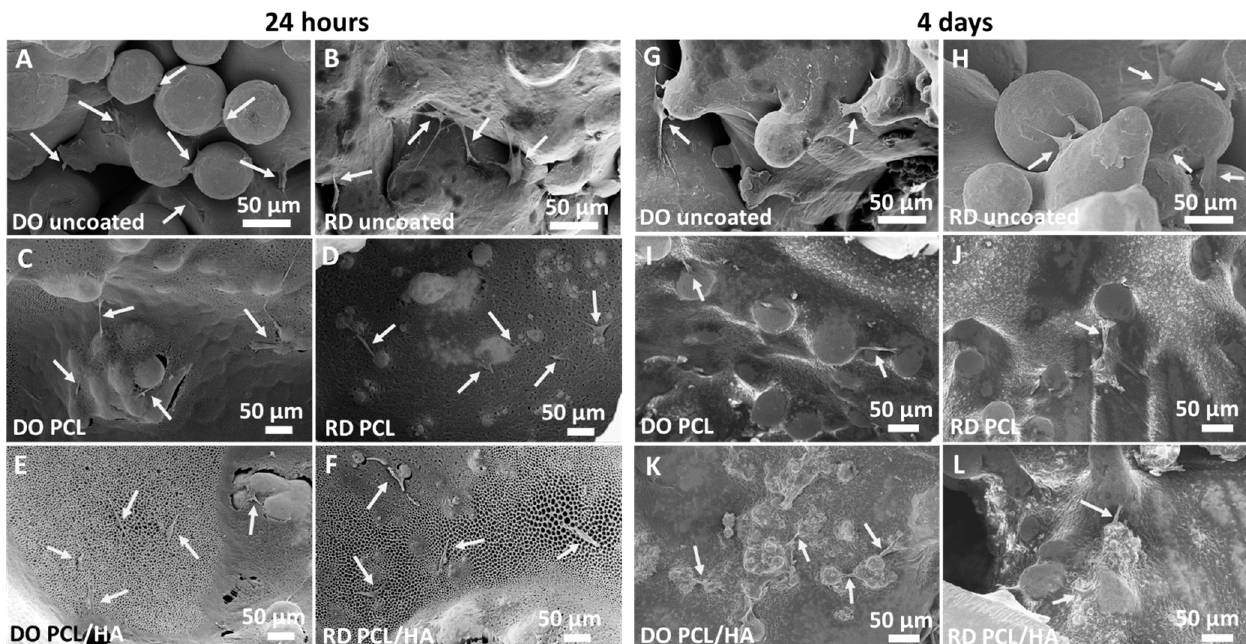
Figure 11. hMSCs after 24 h of incubation on DO and RD ( A ,B) uncoated, ( C , D ) coated with PCL and ( E , F ) with PCL/HA and hMSCs after 4 days of incubation on DO and RD ( G , H )uncoated, ( I , J ) coated with PCL and with ( K , L ) PCL/HA. The hMSCs are indicated by the arrows.